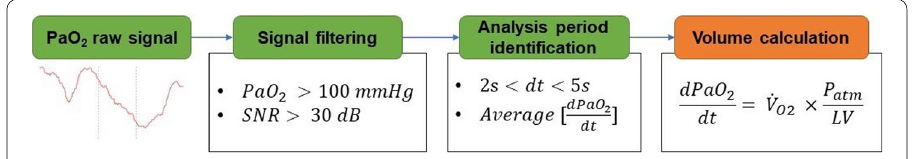
Fig. 1 Algorithm to calculate lung volume available for gas exchange. The text in the coloured boxes summarises the main steps in the algorithm leading to the equation used for the calculation of lung volume available for gas exchange. The text in the white boxes presents the physiological and signal conditions imposed a priori for the automatic processing and analysis of the raw PaO 2 signal, necessary for a bias-free selection of the representative period that was used for the automatic calculation of lung volume available for gas exchange. Additional methodological details are presented in the methods. PaO 2 arterial partial pressure of oxygen; SNR: signal-to-noise ratio; V ̇ O2 : oxygen uptake; P atm : atmospheric pressure; LV: lung